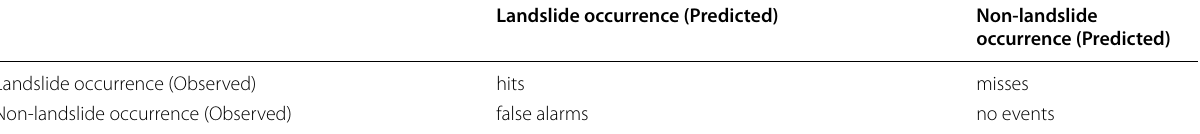
Landslide occurrence (Predicted) Non-landslide